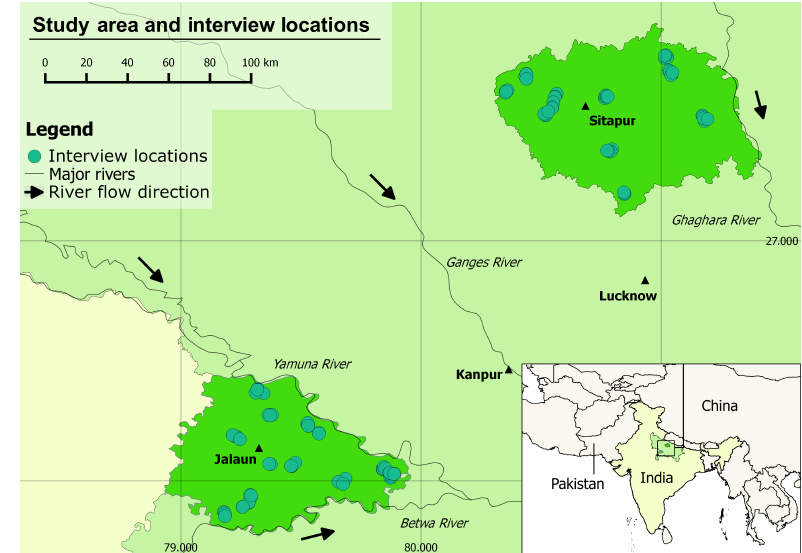
Figure 1. Map of the study region including the locations of the field interviews carried